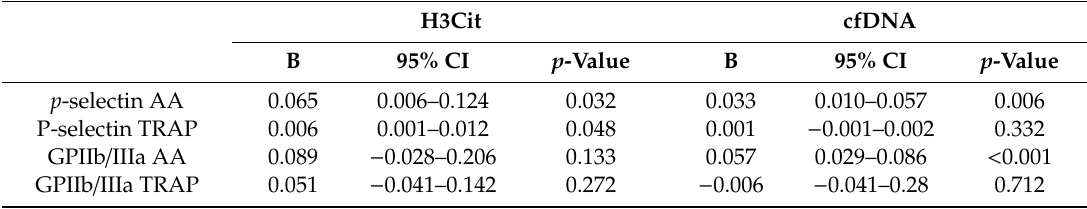
Table 3. Relationships of circulating H3Cit and cfDNA with the parameters of platelet reactivity in multivariate linear regression analysis. H3Cit cfDNA B 95% CI p -Value B 95%